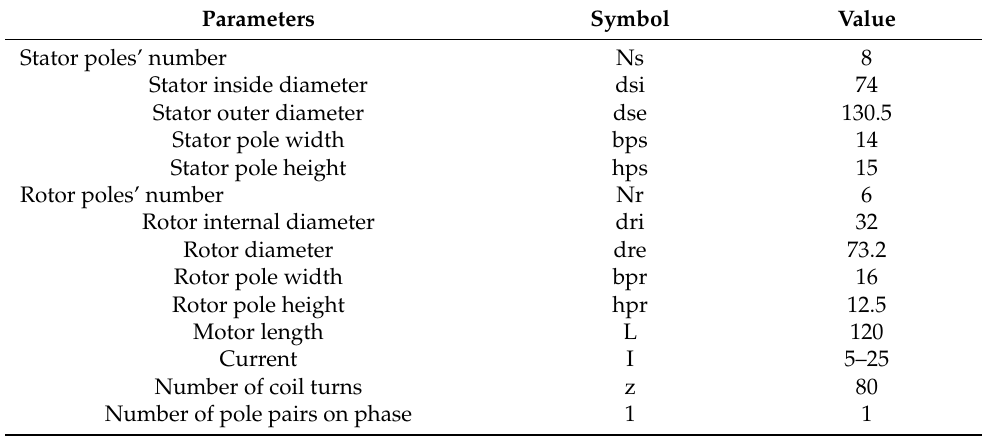
Table 4. Parameters used for model procurement of the 8/6 motor.